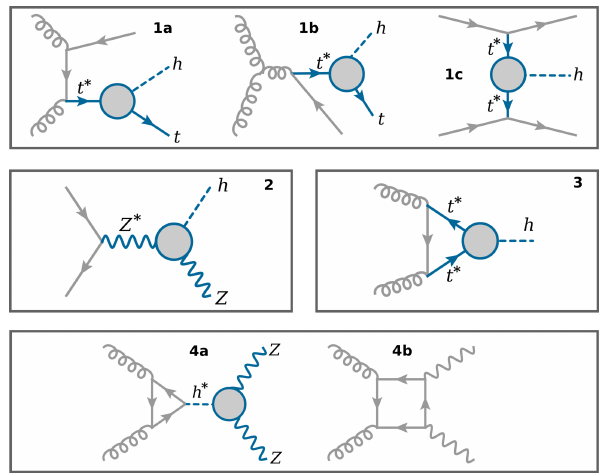
Figure 9 . Relevant channels for the appearance of momentum effects through the form factor vertices. The tth channel (1) presents an off-shell top quark and the Zh (2) an off-shell